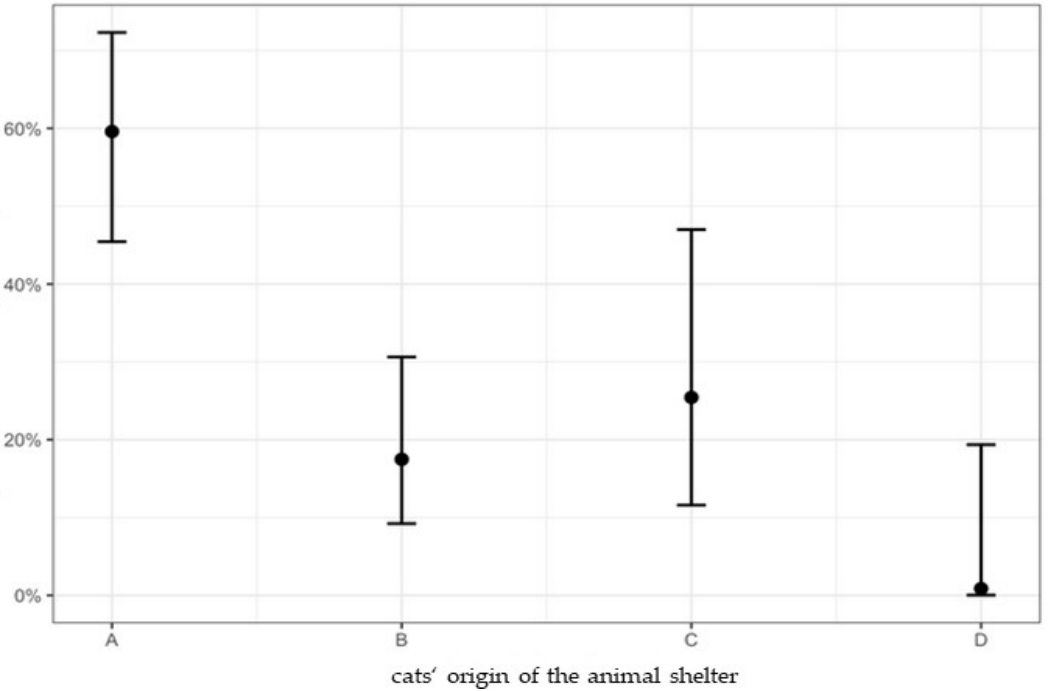
Figure 1. Percentage of cats with feline panleukopenia in shelter A, B, C, and D with 95% confidence intervals. In shelter A, 59.6% (95% CI: 45.4–72.3%) of cats, in shelter B, 17.5% (95% CI: 9.2–30.6%) of cats, in shelter C, 25.4% (95% CI: 11.6–47.0%) of cats, and in shelter D, 0% (95% CI: 0–19.4%) of cats had feline panleukopenia. Univariate Bayesian logistic regression revealed that cats from shelter A had a significantly higher risk for feline panleukopenia in comparison to cats from shelter B, C, and